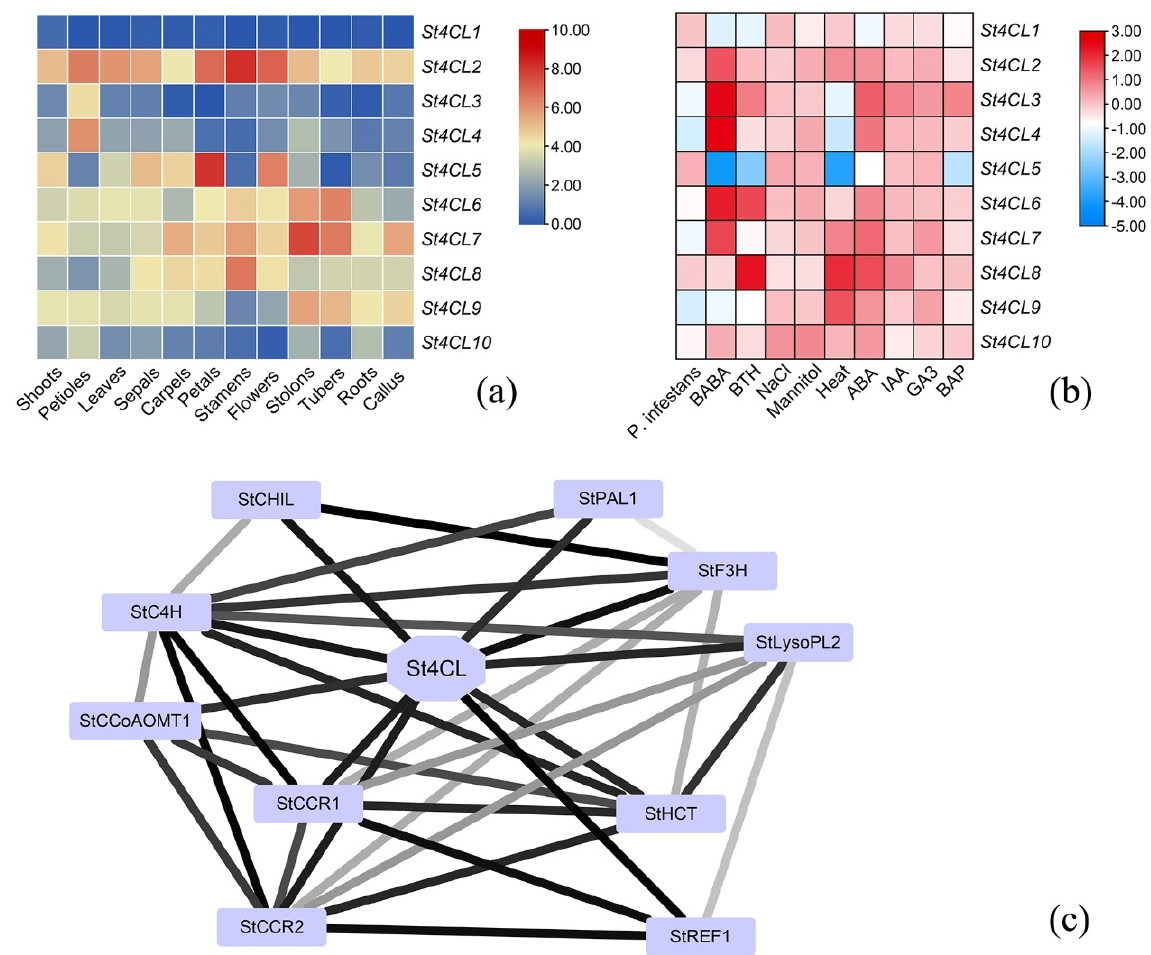
Figure 7. Analysis of St4CLs expression based on transcriptional data as well as protein interaction network analysis of St4CL gene family. ( a ) Gene expression profiles of St4CLs in different tissues of potato. ( b ) St4CLs expression changed under different adversity stresses. ( c ) The protein–protein interaction network analysis of the St4CL gene family. Lines represent direct or indirect functional relevance of the two proteins.